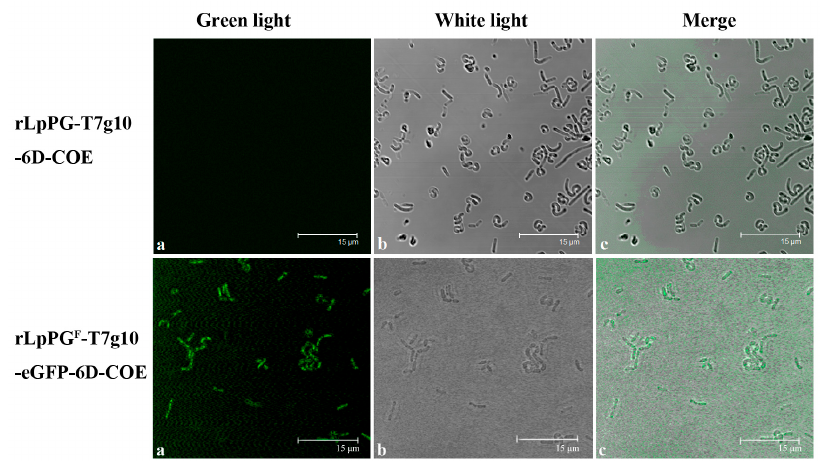
Figure 4. Expression of the PgsA-eGFP-6D-COE fusion protein on the cell surface. The localization of the PgsA-eGFP-6D-COE fusion protein in rLpPG F -T7g10-eGFP-6D-COE was detected by laser confocal microscopy. Bars are 15 µ m for rLpPG F -T7g10-eGFP-6D-COE and rLpPG-T7g10-6D-COE. Recombinant strains were observed by green light ( a ) and white light ( b ) respectively. Panel ( c ) is a merged image of panel ( a , b ).